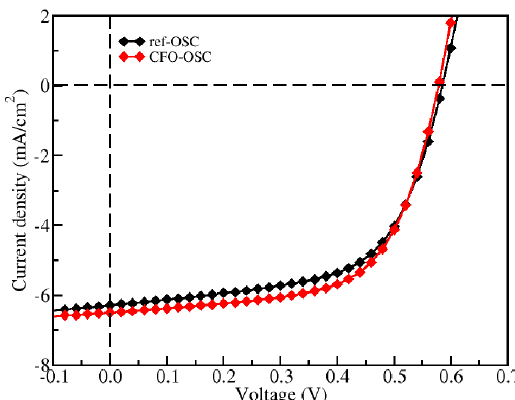
Figure 5. J×V curves of the best ref-OSC and CFO-OSC cells. Under illumination AM 1.5 with the light intensity of 100 mW/cm 2 .